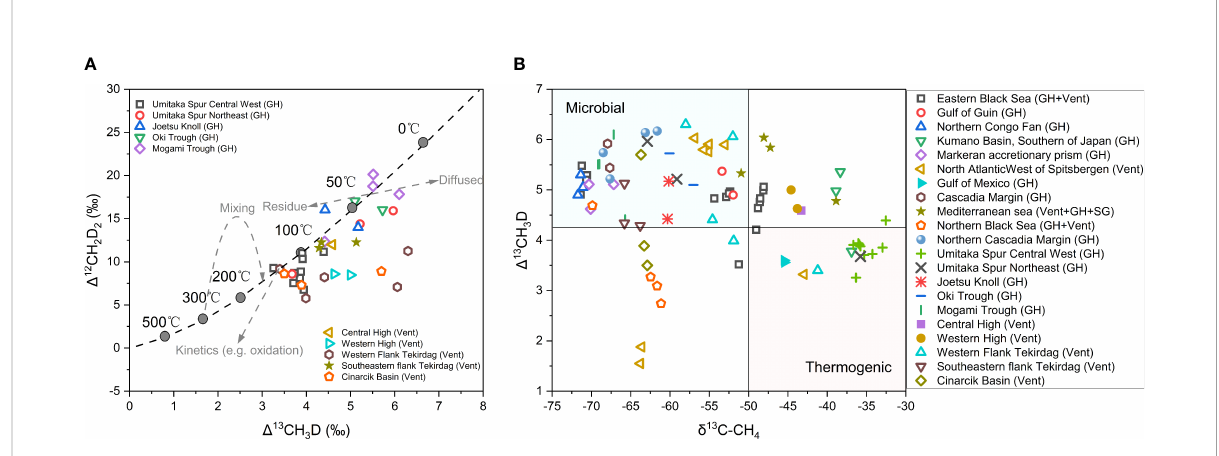
FIGURE 7 (A) Compile of the published clumped isotope of hydrate associated gases plotted in thermodynamic equilibrium curve in D 12 CH 2 D 2 vs. D 13